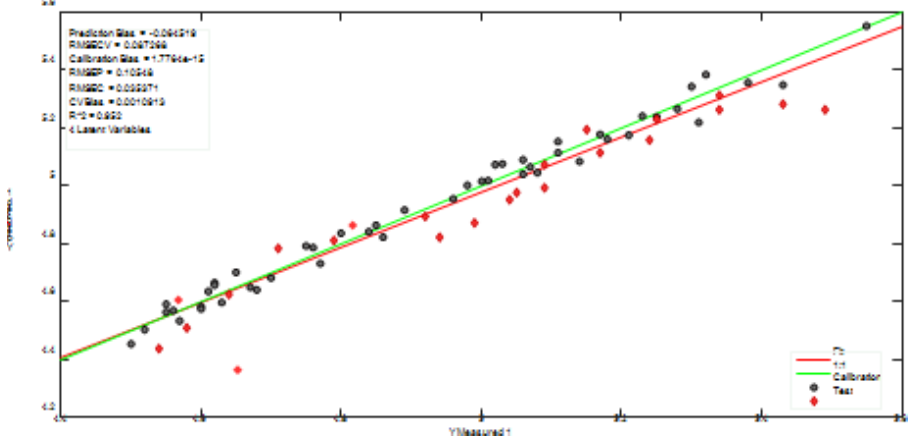
Fig. 3. Model results after FD þ SG smoothing (15 data points, second polynomial order) þ OSC pre-treatment.